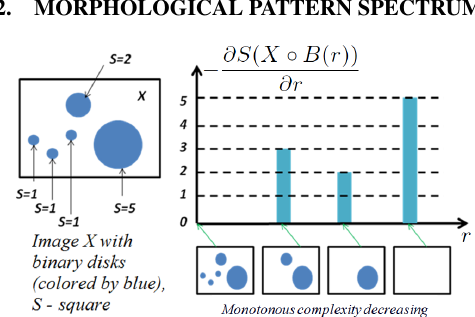
Figure 1: The morphological pattern spectrum of objects in the image X with disc SE and the stages of its morphological pro-